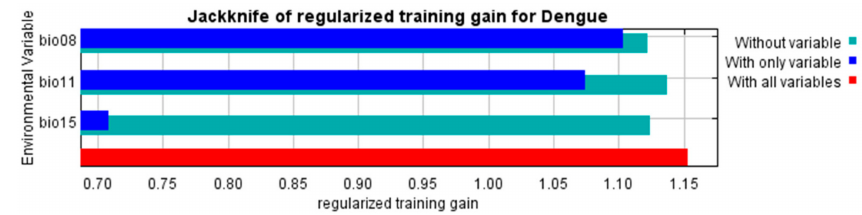
Figure 3. Variable importance by Jackknife test. The blue, aqua and red bars represent the results of the model created with each individual, all remaining variables and all the variables